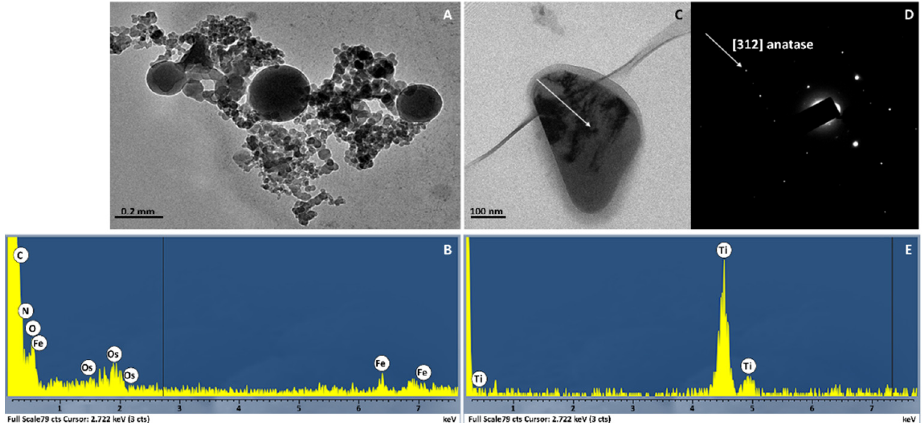
Figure 6. ( A ) Brightfield TEM image of representative nanostructures observed in Ce 1000 leaves; ( B ) EDXS spectrum as acquired in the particle area shown in brightfield mode; ( C ) Brightfield TEM image of Ti nanostructures in Ti 1000 leaves; ( D ) Nanodiffraction pattern as acquired on individual nanostructures indicated by the arrow in the brightfield image (see text); ( E ) EDXS spectrum as acquired on the region indicated in the brightfield image.